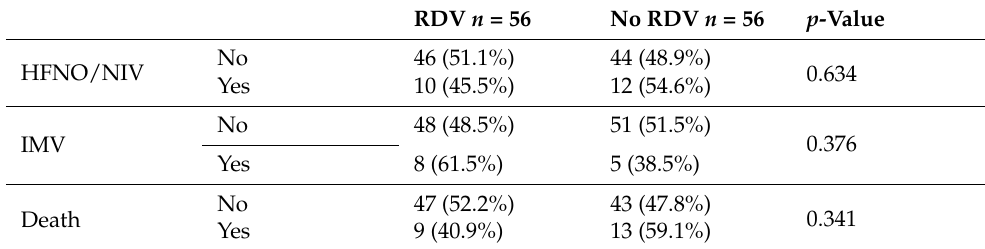
Table 5. Impact of remdesivir therapy on the course of COVID-19 in patients with SARD after